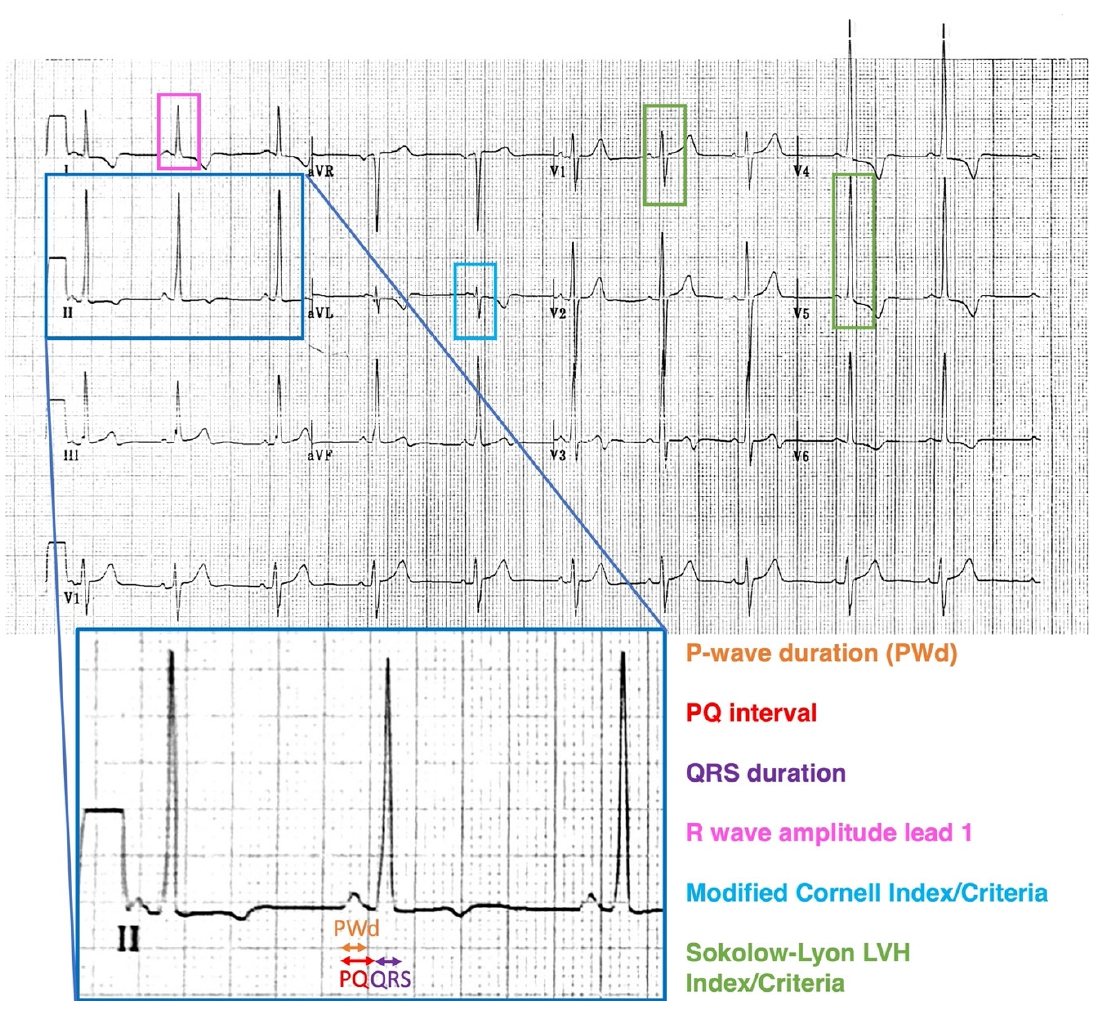
Figure 1. ECG parameters assessed included PQ interval in lead II and lead V1, P wave duration (PWd) in lead II and V1, QRS duration in lead II, R wave amplitude in lead 1, Sokolow–Lyon index and criteria, Modified Cornell index and criteria and complete right bundle branch block criteria. Table 1. ( A ). Electrocardiographic characteristics of FD patients compared to age and gender matched normal controls. ECG parameters assessed are listed in the first column. Comparison is made between FD patients and matched controls; between male FD patients and matched male controls only; and between female FD patients and matched female controls only. ( B ) Comparison between the electrocardiographic characteristics of male FD patients and female FD patients. ECG parameters assessed are listed in the first column.